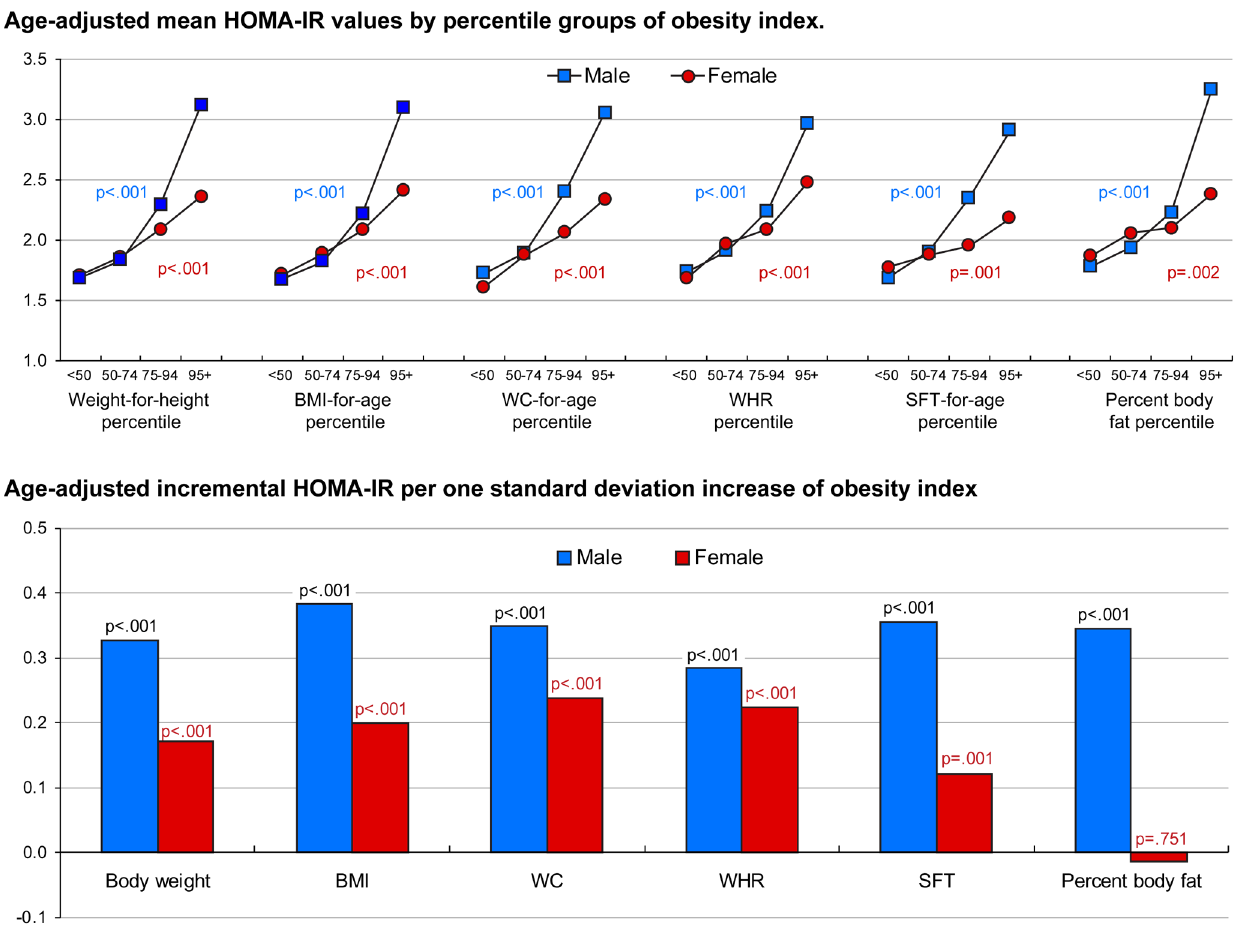
Fig 1. HOMA-IR Levels according to Different Obesity Indices in Male and Female Adolescents. Abbreviations: HOMA-IR, Homeostasis model assessment insulin resistance; BMI, body mass index; WC, waist circumference; WHR, waist-to-hip ratio; WHtR, waist-to-height ratio; SFT, skin-fold thickness. Percent body fat was measured for 541 adolescents (277 males and 264 females). Upper panel shows age-adjusted mean HOMA-IR values by percentile groups for weight-for-height, BMI-for-age, WC-for-age, WHR, WHtR, SFT-for-age, and percent body fat in male and female adolescents. Lower panel shows age-adjusted incremental HOMA-IR per one standard deviation increase in body weight, BMI, WC, WHR, WHtR, SFT and percent body fat in male and female adolescents.